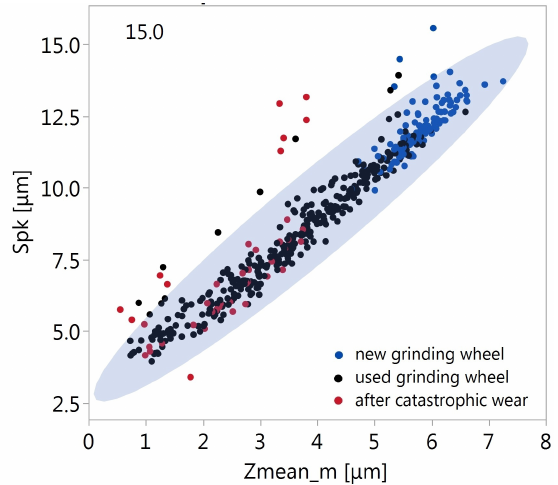
Figure 6. Relationship between parameters Spk and Zmean_m (ellipse—95%